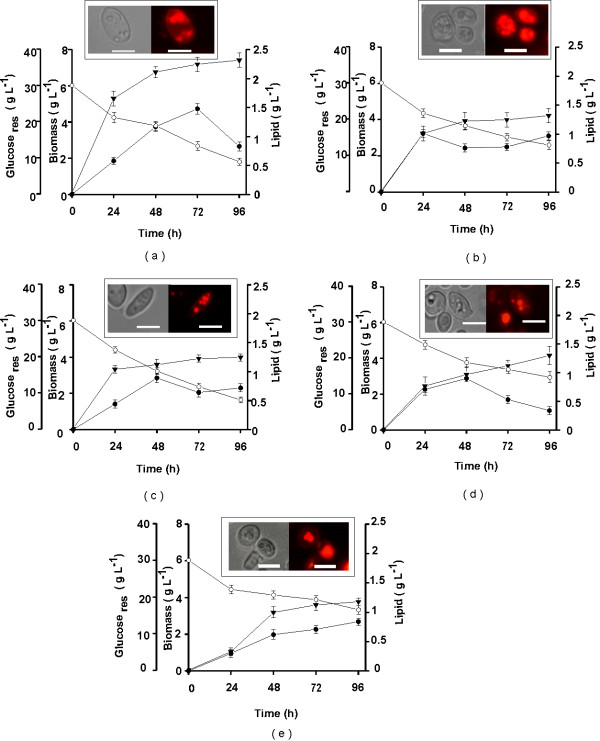
Kinetics of biomass, residual glucose and cellular lipids of Y. lipolytica strains grown on glucose. Strains (a) 3229, (b) 3450, (c) 3472, (d) 3589 and (e) 3590 were grown on 30 g L-1 glucose as mentioned in Materials and Methods. All values are represented as Mean ± SD, determined after 3 independent experiments. Biomass (g L-1) - ▾, Lipid (g L-1) - •, Glucose res (g L-1) - ○. Inset In each graph light microscopy (left panel) and Nile red fluorescence microscopy (right panel) images of the respective Y. lipolytica strains under 100x oil immersion objective. Bar indicates 10 μm for a, c and d and 5 μm for b and e.